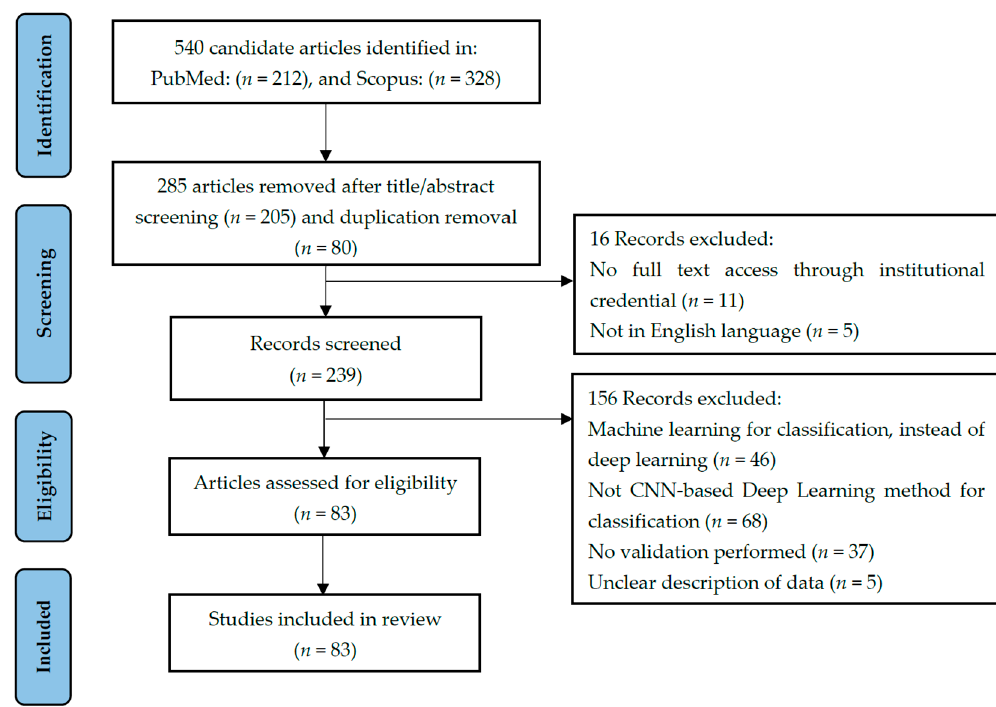
Figure 1. The PRISMA flowchart of this review. n : number of articles.